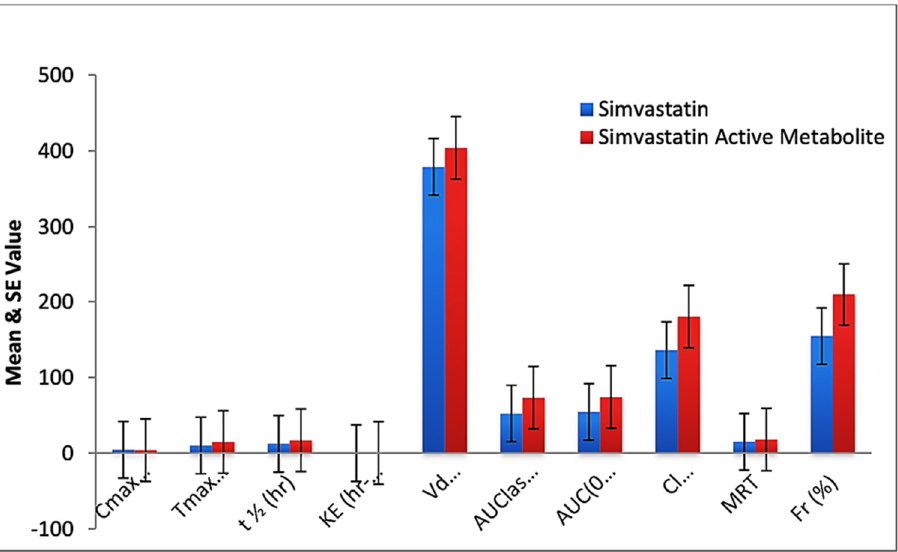
Figure 8. Comparison of pharmacokinetic parameters of simvastatin and simvastatin active metabolite in plasma of CS-SS nanoformulation-treated rabbit.